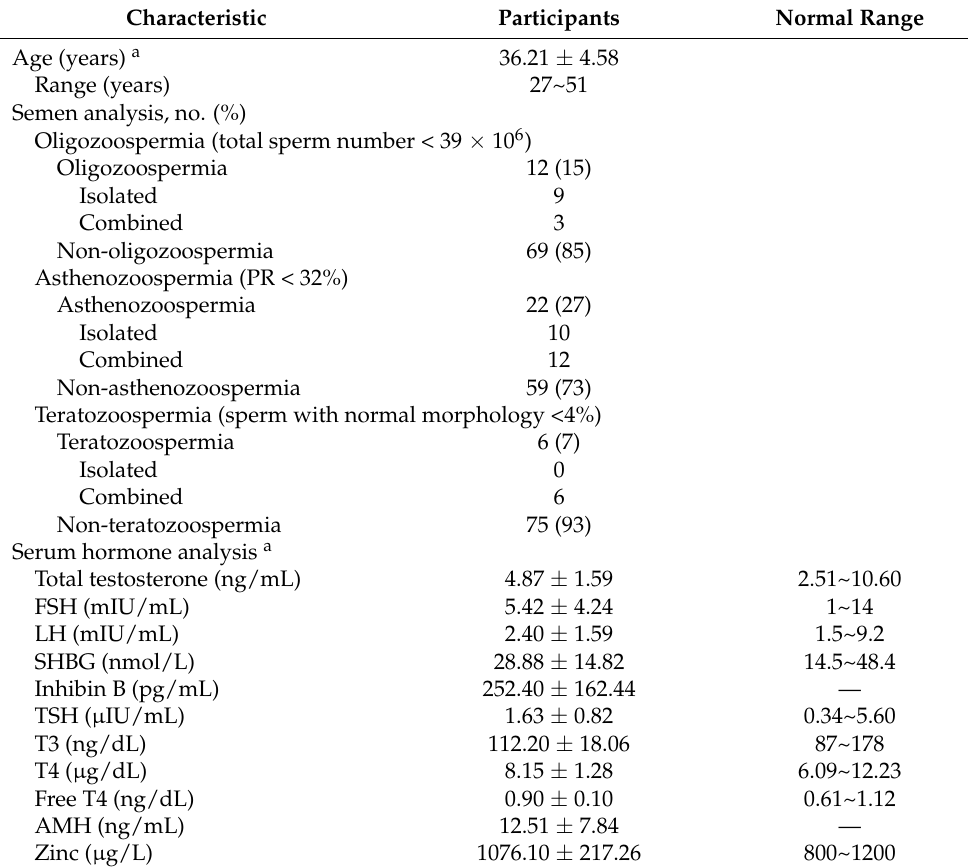
Table 1. Characteristics of the 81 male participants.